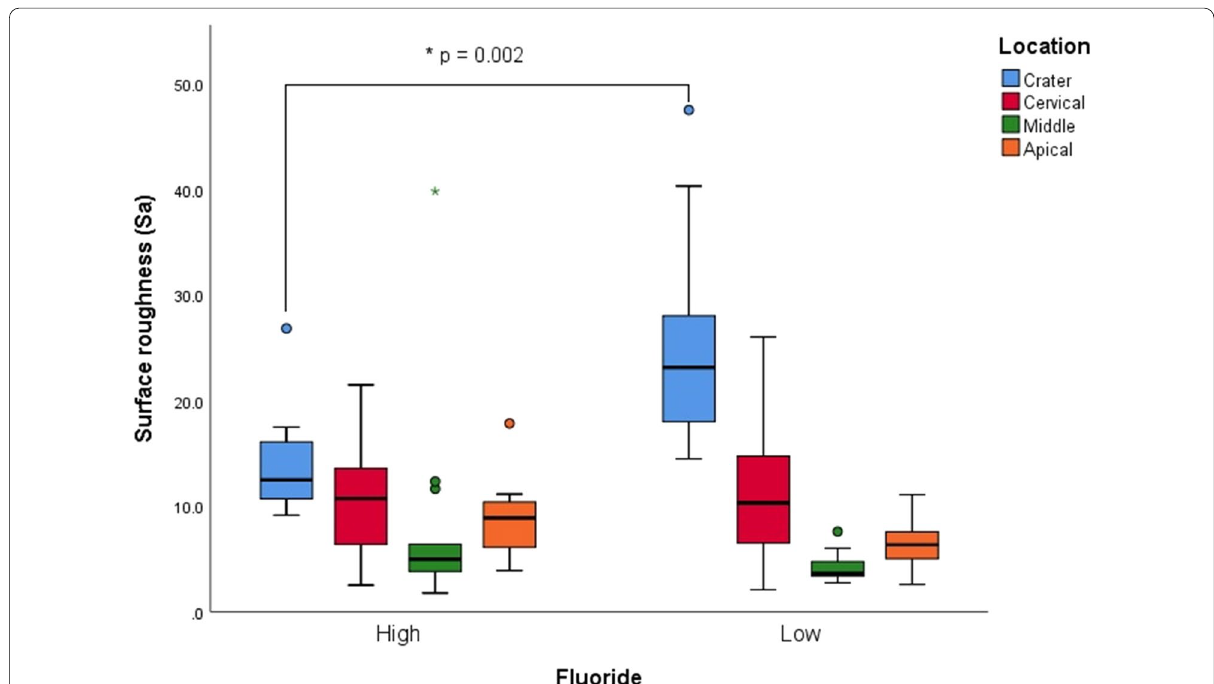
Fig. 6 Box plot of surface roughness for high‑ and low‑fluoride groups